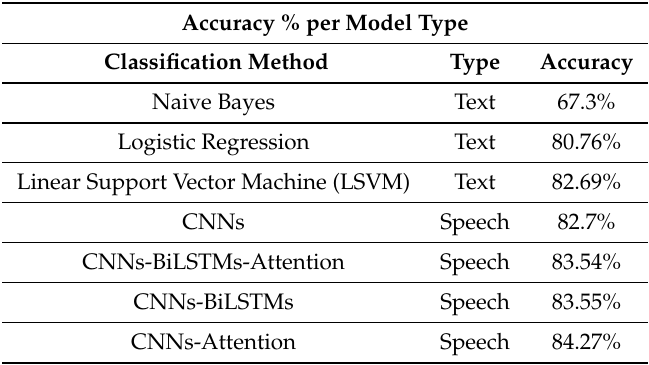
Table 3. Accuracy (Speech–Text)